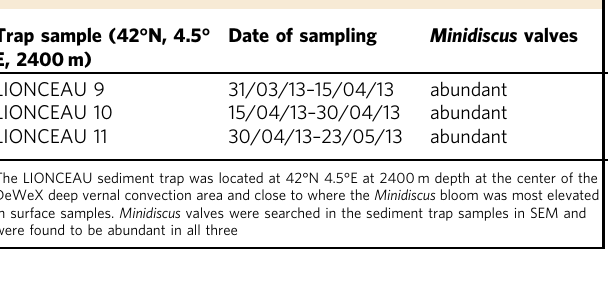
Table 2 Observations of Minidiscus valves in the LIONCEAU sediment trap samples during